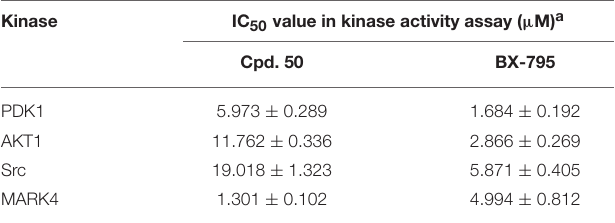
TABLE 2 | Kinase assay of molecules using PDK1, AKT1, Src, or MARK4 as enzyme. Kinase